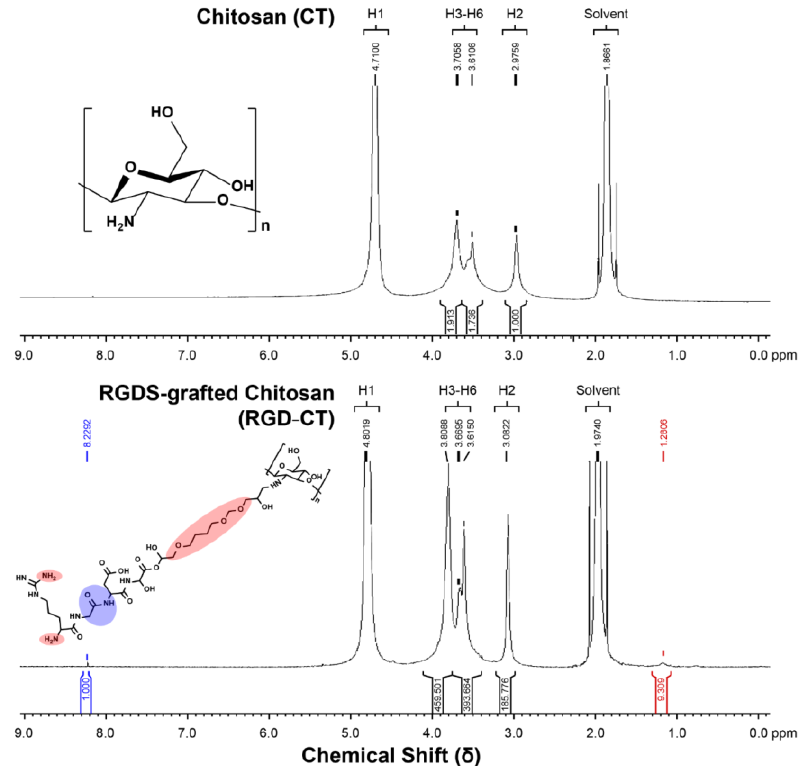
Figure 3. The NMR an alysi s of 90% deacetylated chitosan and the RGD−Chitosan conjugate.